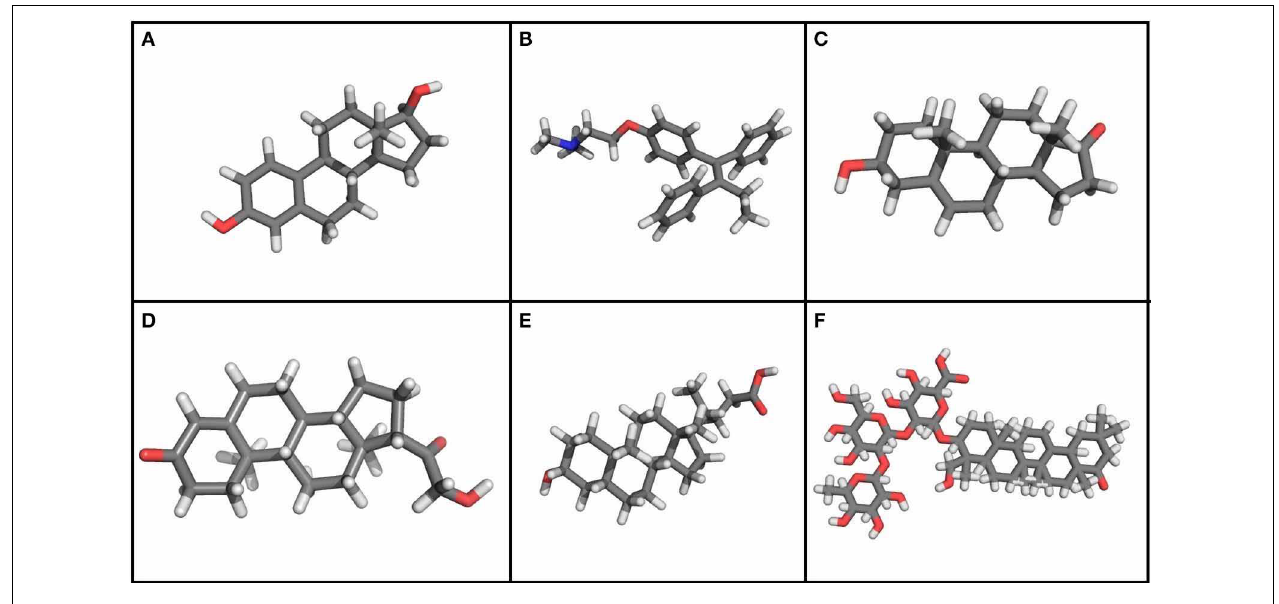
FIGURE 7 | Chemical structure of steroids and other molecules that modulate BK channel activity. (A) 17 β -Estradiol. (B) Tamoxifen. (C) Dehydroepiandrosterone. (D) Corticoesterone. (E) Lithocholic acid. (F)